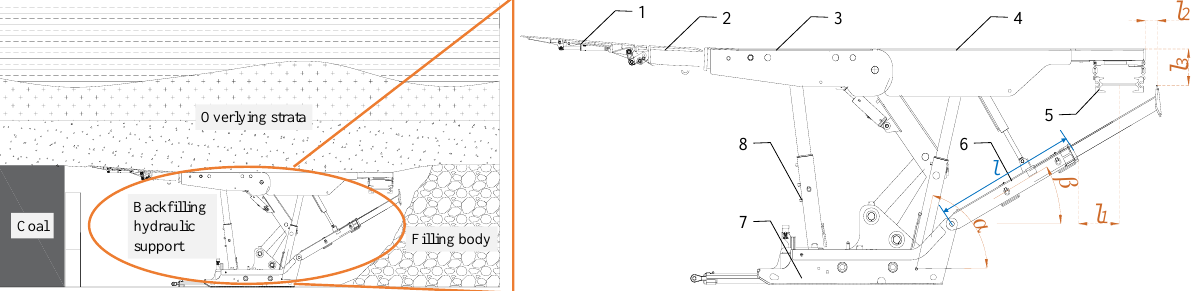
Figure 2. Illustration of the definitions of various indices (1 — side-protecting plate; 2 — front beam; 3 — top beam; 4 — rear top beam; 5 — scraper conveyor; 6 — tamping structure; 7 — base; 8 — column; α — column inclination; β — tamping angle; l — length of tamping mechanism when retracting; l 1 — gap distance of blanking; l 2 — empty support distance; l 3 — distance from the top).